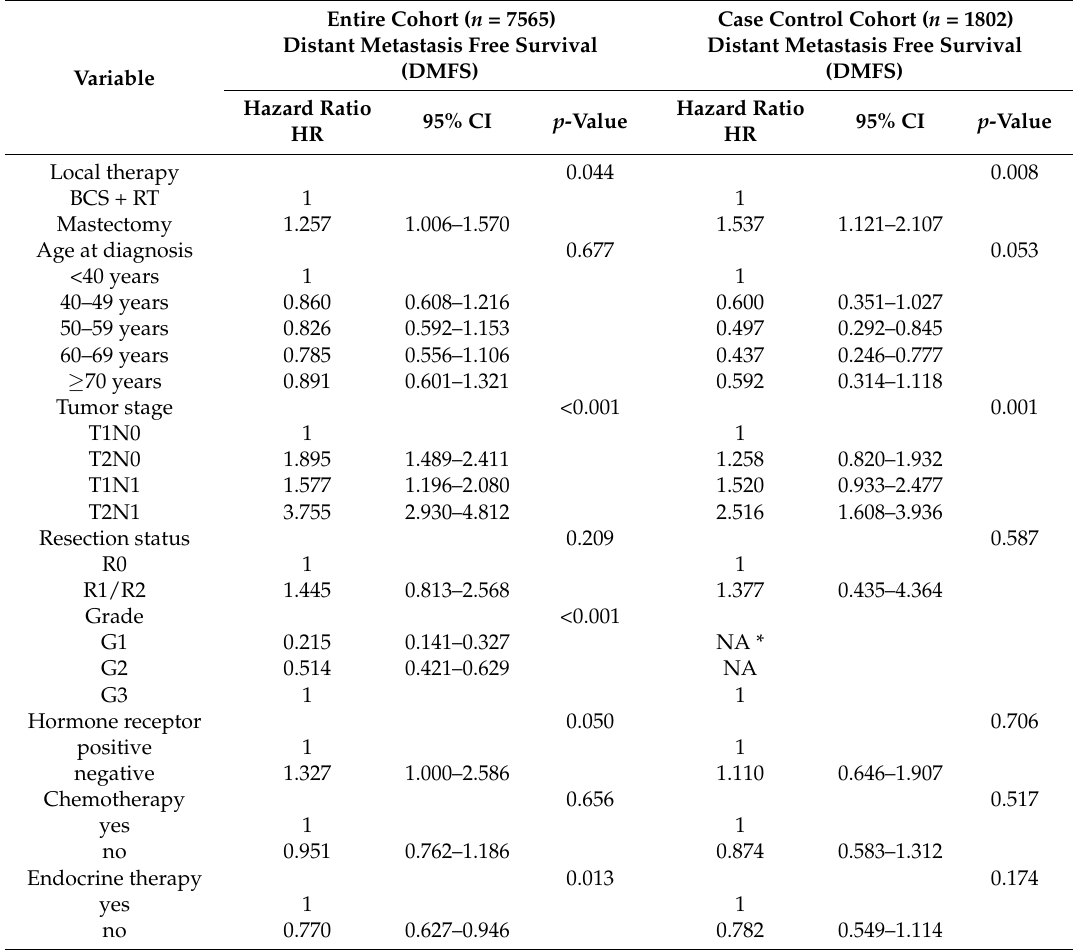
Table 5. Multivariable Cox regression analysis for distant metastasis free